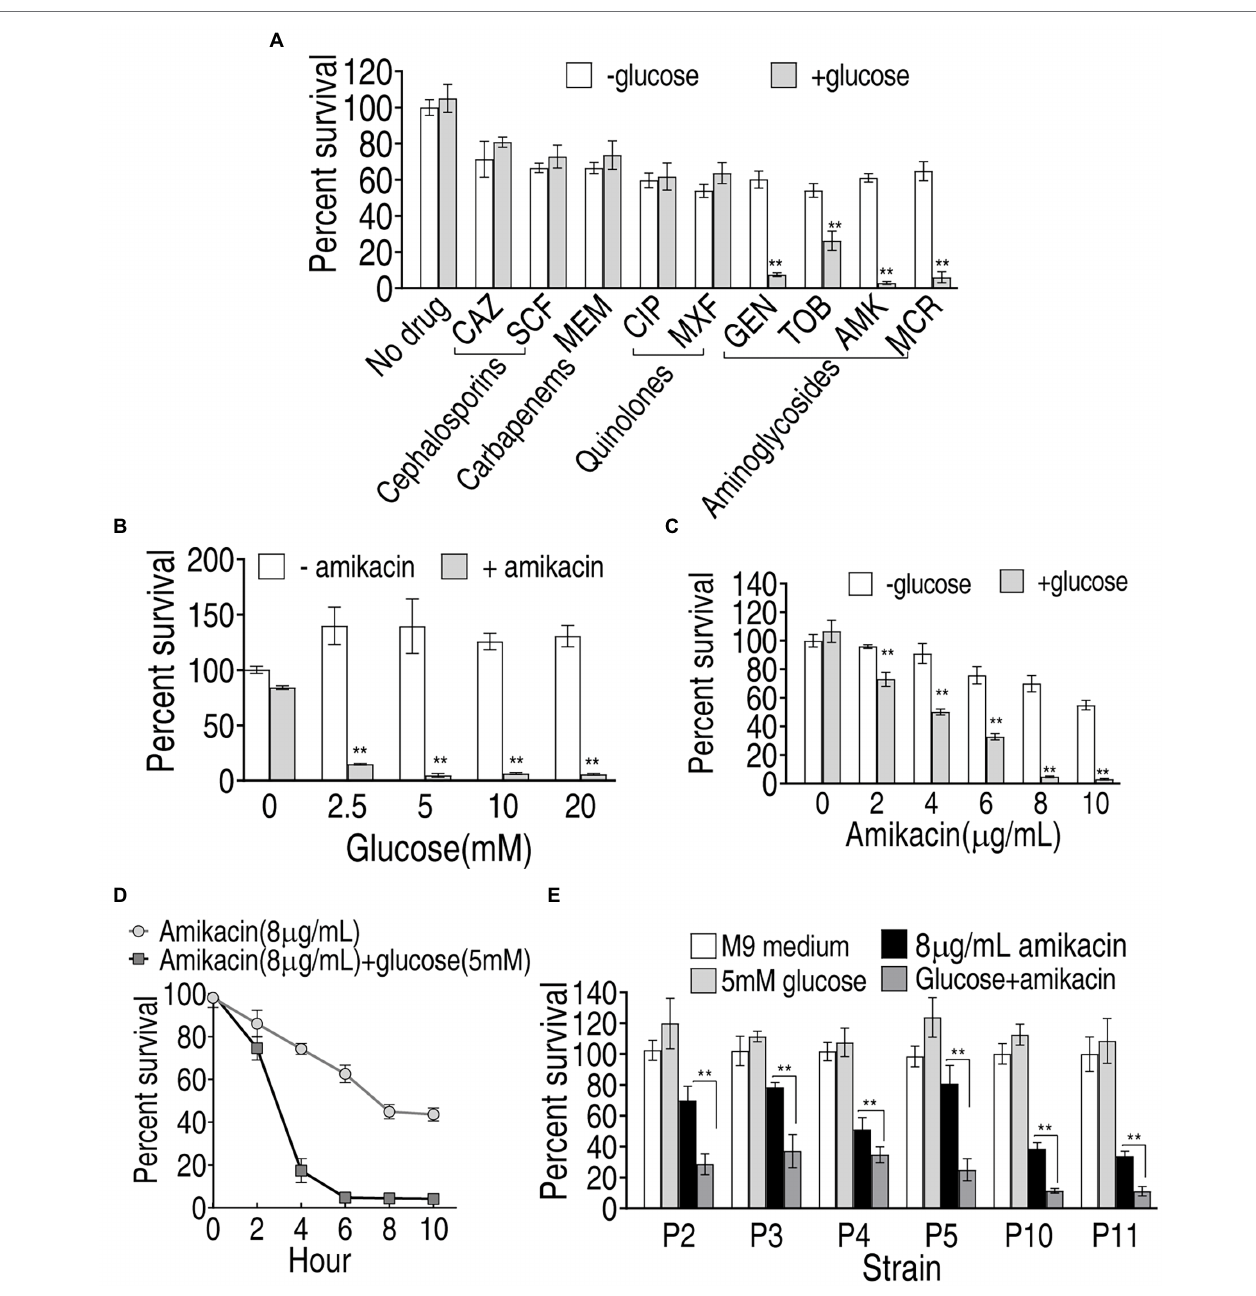
FIGURE 6 | Viability of PA-R16 SCF and clinically multidrug-resistant P. aeruginosa in the presence of glucose plus antibiotics. (A) Percent survival of PA-R16 SCF in the presence of the indicated antibiotics. (B) Percent survival of PA-R16 SCF in the presence of the indicated concentrations of glucose plus amikacin. (C) Percent survival of PA-R16 SCF in the presence of the indicated concentrations of amikacin plus glucose. (D) Percent survival of PA-R16 SCF in the indicated incubation periods and in the presence of amikacin plus glucose. (E) Percent survival of clinically multidrug-resistant P. aeruginosa in the presence of glucose and amikacin. Results are displayed as mean ± SEM and three biological repeats are performed. Significant differences are identified ** p <